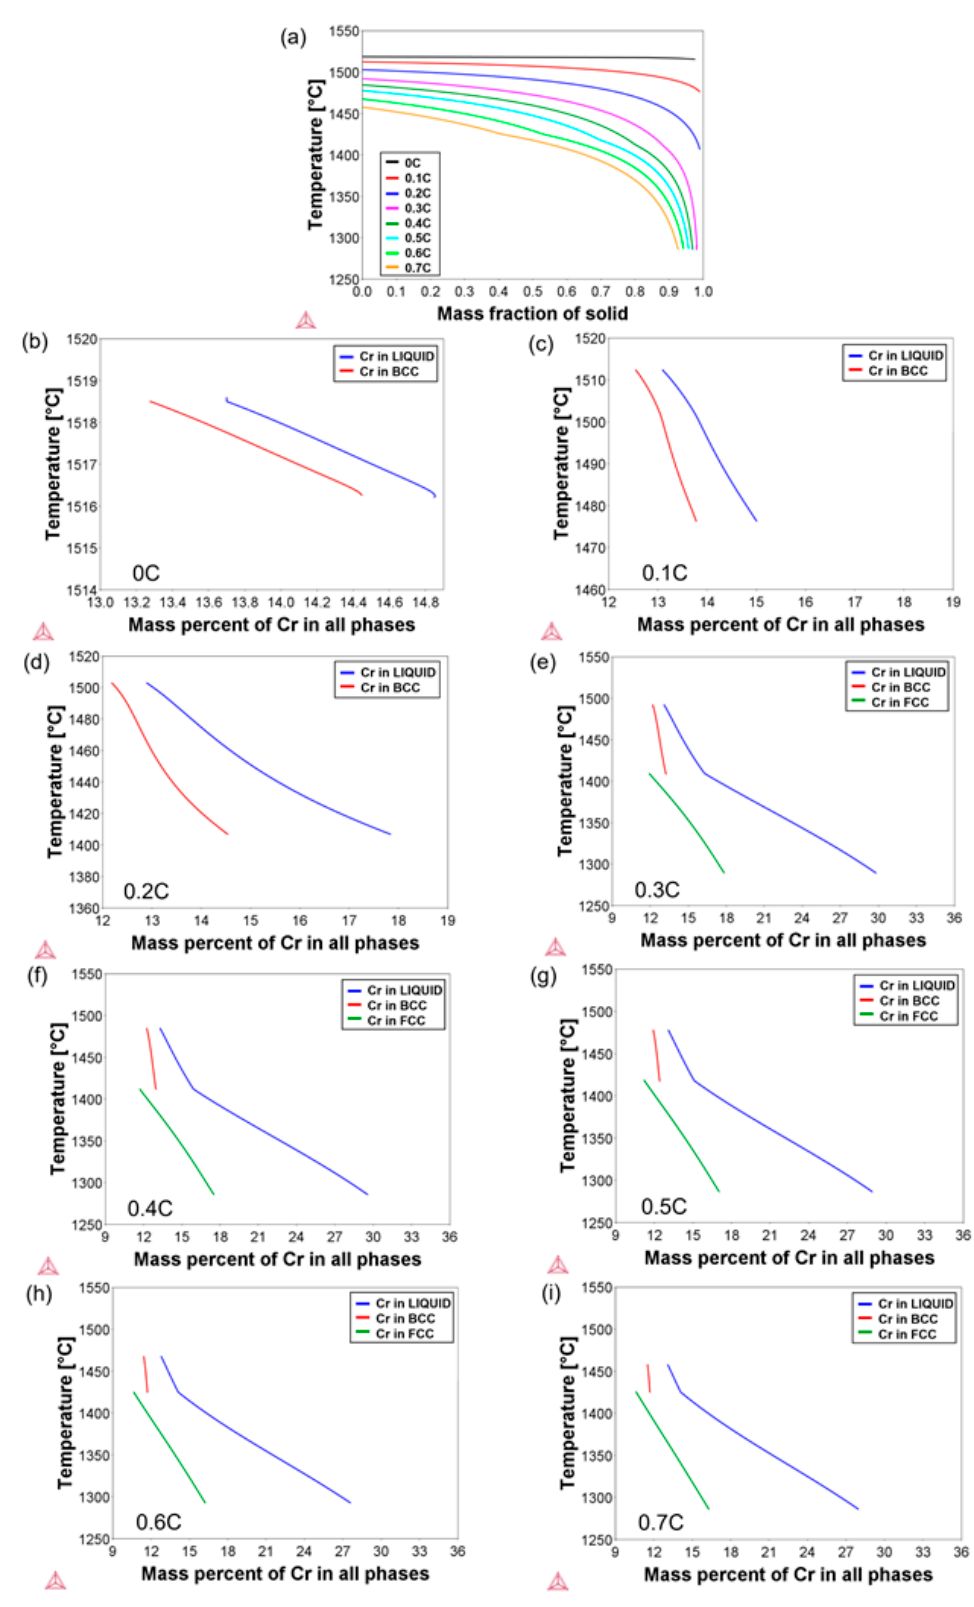
Figure 4. ( a ) Scheil-predicted solidification ranges of the steels; ( b – i ) calculated concentrations of Cr in liquid, ferrite, and austenite phases as a function of temperature during solidification of alloys. Simulations were terminated after reaching a threshold liquid phase fraction of 1%.